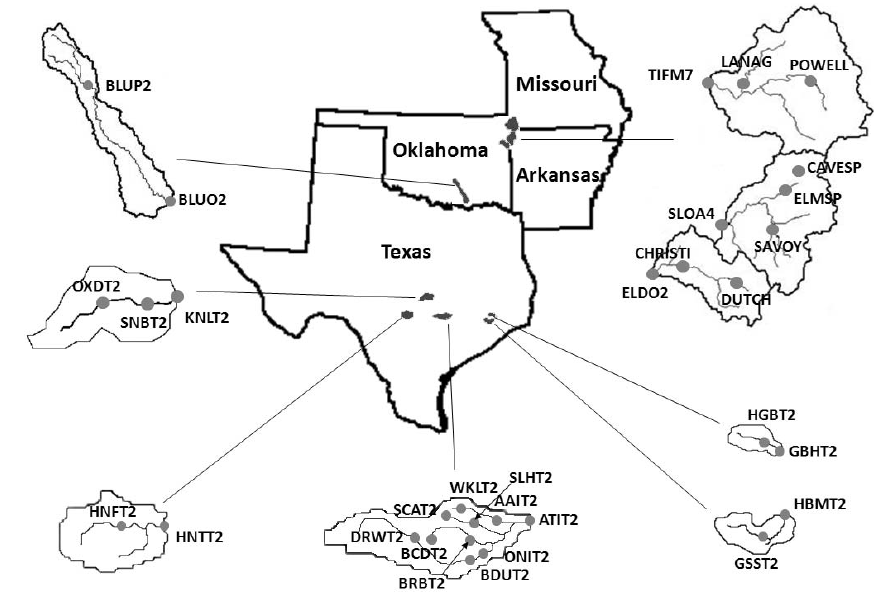
Fig. 2. Map showing the locations of study basins, channel network and stream Fig 2. Map showing the locations of study basins, channel network, and stream gauges 806